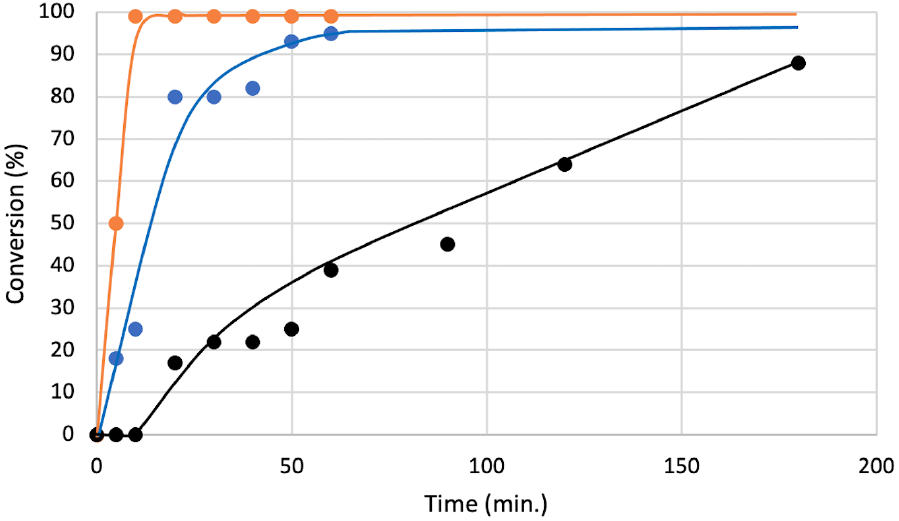
Figure 6. Conversions of 5a in an optimal condition (Table 1, Entry 1) with different catalyst (black: without catalyst, blue: with 4a (2.5 mol%), orange: with 8 (2.5 mol%)) monitored by 1 H NMR.